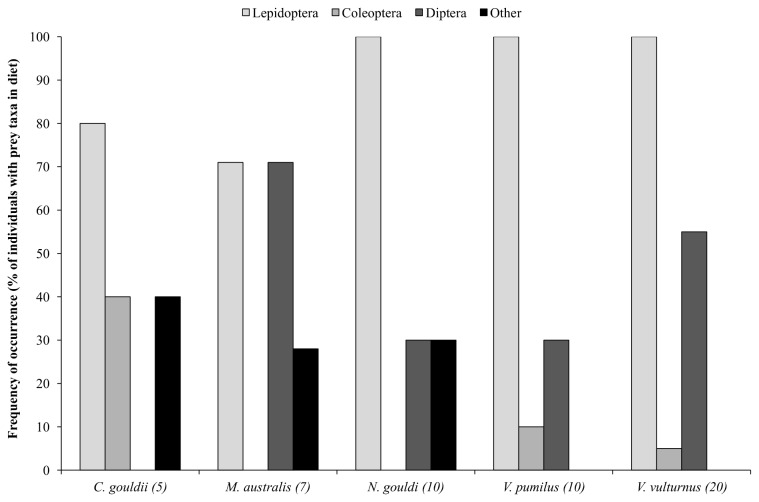
Bat diets.Frequency of occurrence of each insect taxa in the diets of the five insectivorous bats (i.e., percentage of individuals of a species that consumed each insect taxa).